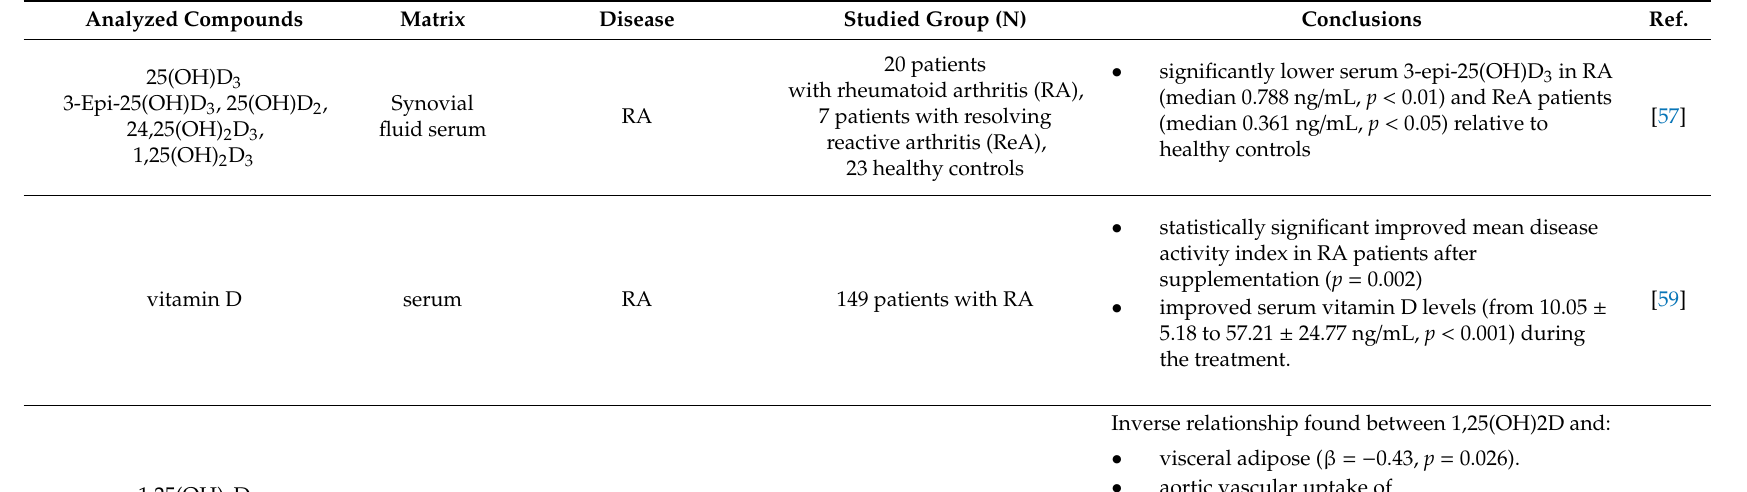
Table 2. Analysis of vitamin D status in various